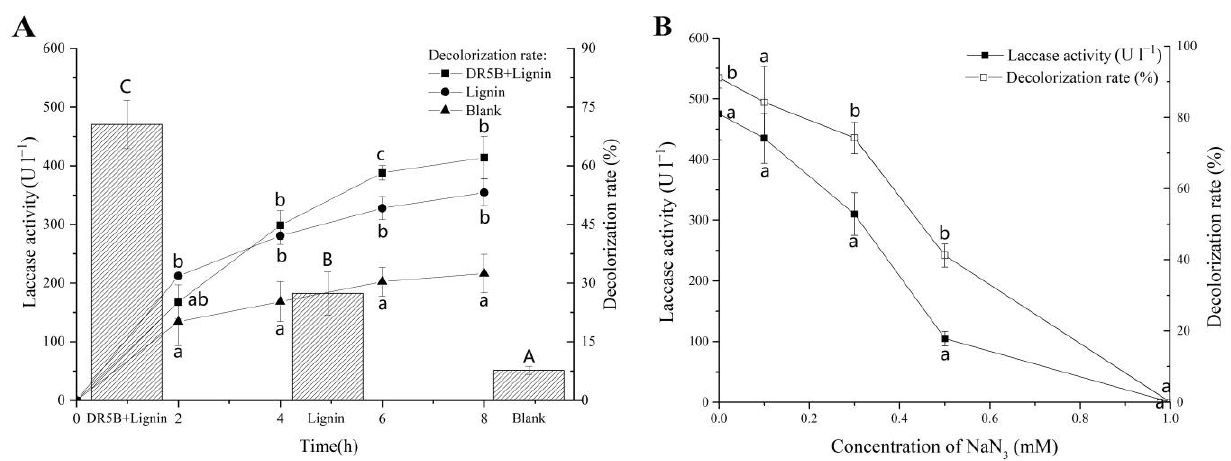
Figure 4. Effect of cell-free extracellular liquid (CFEL) and inhibition of laccase on DR5B decolorization. ( A ) Decolorization of DR5B (25 mg L − 1 ) by the CFEL extracted from G. lucidum EN2 incubated with or without lignin and DR5B for 48 h. “DR5B+Lignin”: CFEL obtained from G. lucidum EN2 incubated with lignin and DR5B and added Kirk medium; “Lignin”: CFEL extracted from G. lucidum EN2 fermented with lignin and added Kirk medium; “Blank”: CFEL extracted from G. lucidum EN2 fermented with Kirk medium only; ( B ) Inhibition of laccase and decreased decolorization with increasing sodium azide concentration. The vertical line on each bar indicates the standard deviation for three replicates (SD, n = 3). Different letters represent significant differences between treatment groups at each time point, as determined with a two-way ANOVA followed by LSD or Tukey multiple comparison tests ( p < 0.05).